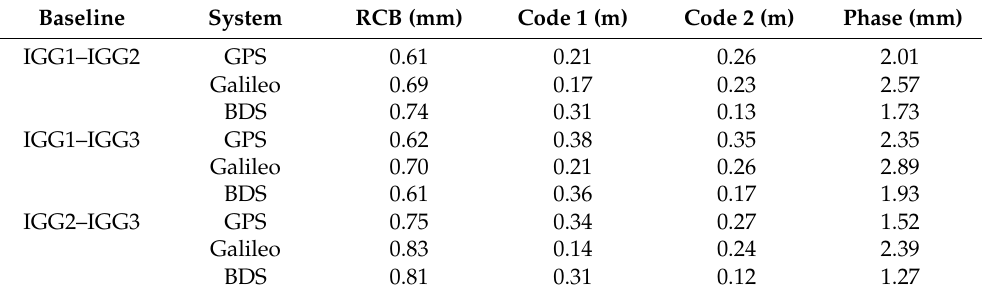
Figure 7. Estimated STD of the GPS, Galileo, and BDS RCB process noise calculated using the IGG1–IGG2 baseline data collected on DOY 268, 2019. Table 2. Estimated STDs of the GPS, Galileo, and BDS observation noise and of the RCB process noise for three